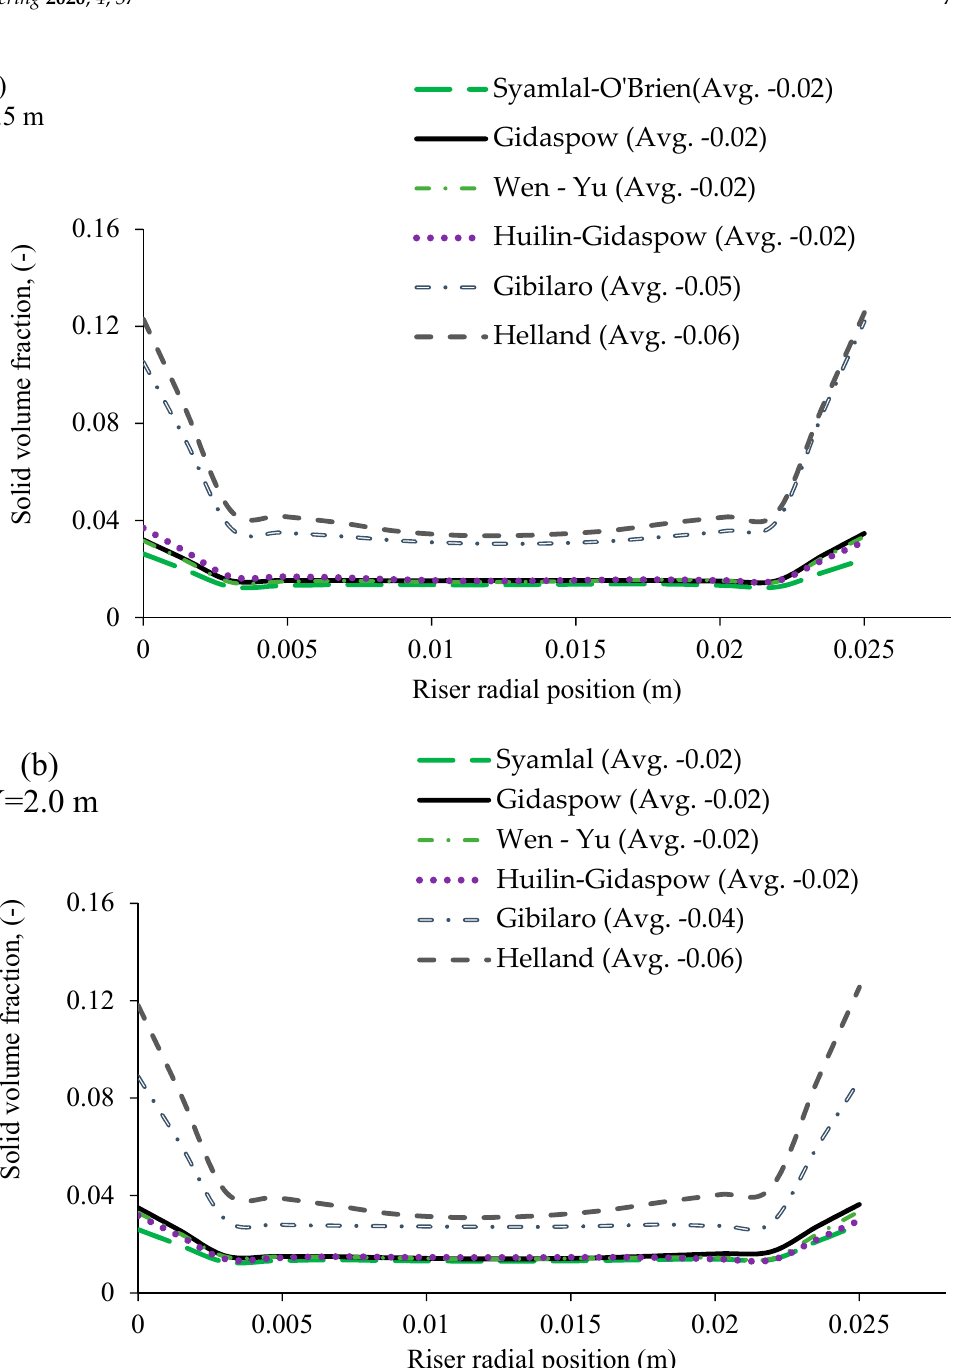
Figure 4. Time-averaged radial solid volume fraction for Syamlal-O’Brien, Gidaspow, Wen-Yu, Huilin-Gidaspow, Gibilaro and Helland drag models at height of ( a ) 1.5 and ( b ) 2 m.